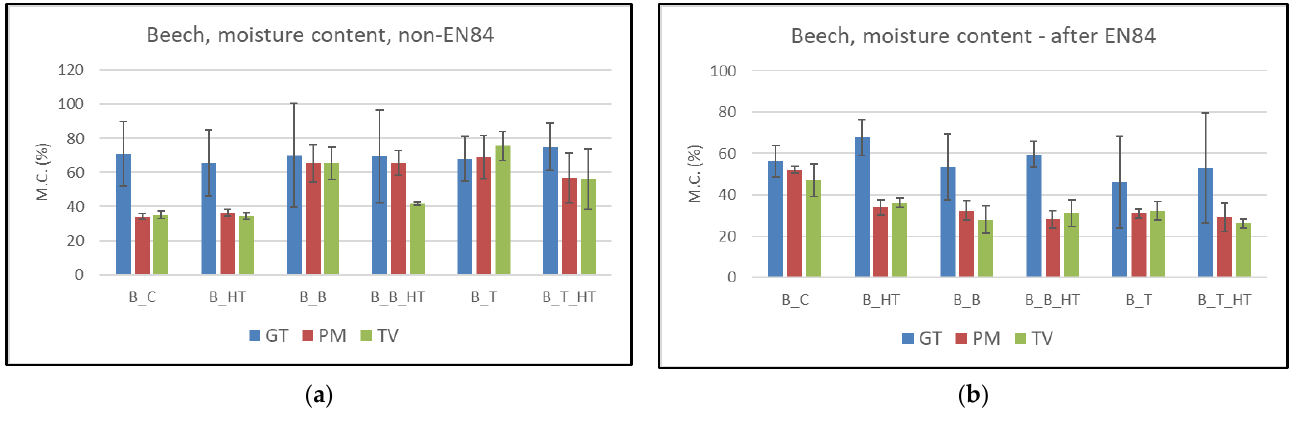
Figure 7. Moisture content of beech measured during fungal decay, ( a ) without EN84 weathering; ( b ) with EN84 weathering. GT— G. trabeum , PM— P. monticola , TV— T. versicolor .